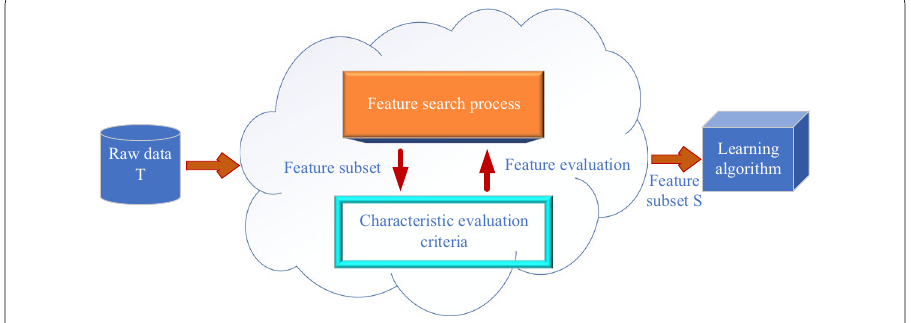
Fig. 6 Working flow of wrapping selection